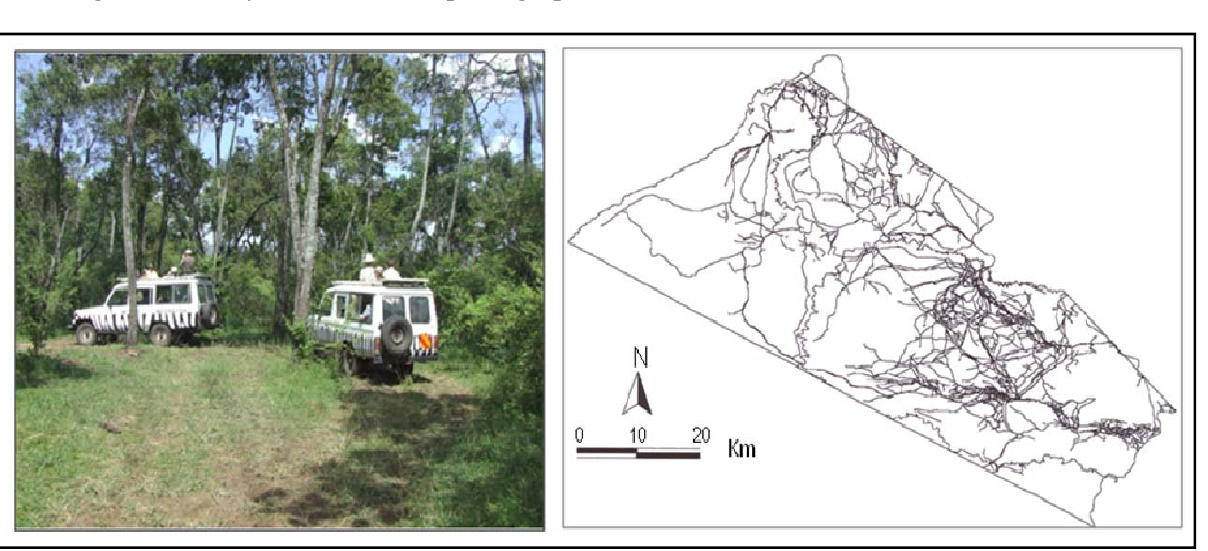
Figure 9. Off-road driving in the Masai Mara National Reserve as tourist vehicles